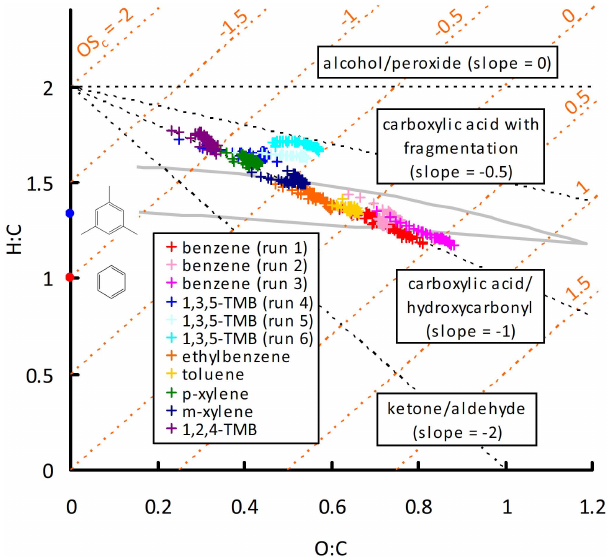
Fig. 1. Van Krevelen diagram of SOA formed from the photooxi- dation of aromatic hydrocarbons in the presence of NO x ; data of benzene and 1,3,5-trimethylbenzene shown with a run number are present results; data of other hydrocarbons are taken from Sato et al. (2010); data from ambient organic aerosol measurements appear in a region surrounded by gray curves (Ng et al.,